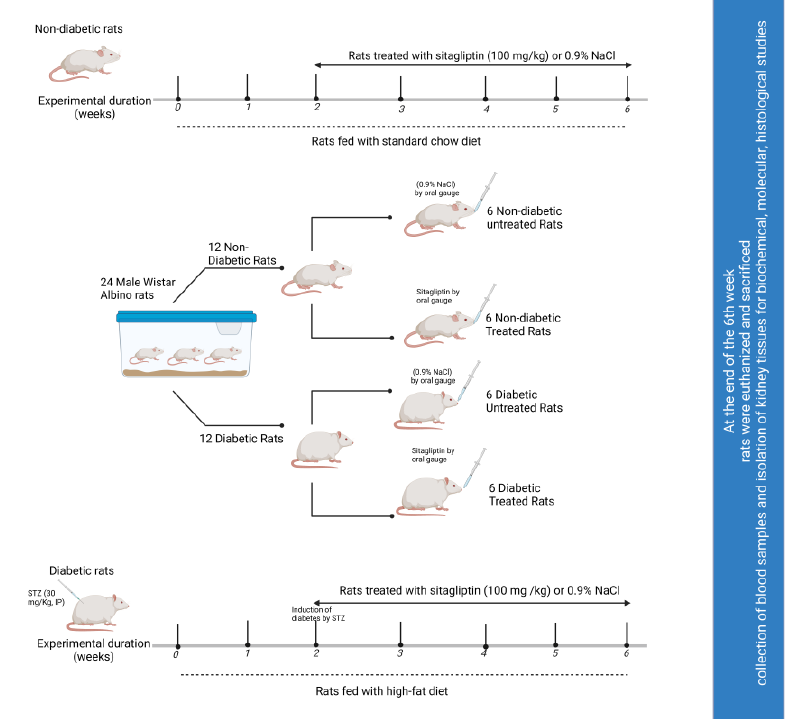
Figure 1. Schematic representation of the experimental design. Table 1. Effects of sitagliptin on DN biomarkers in STZ-induced diabetic rats.